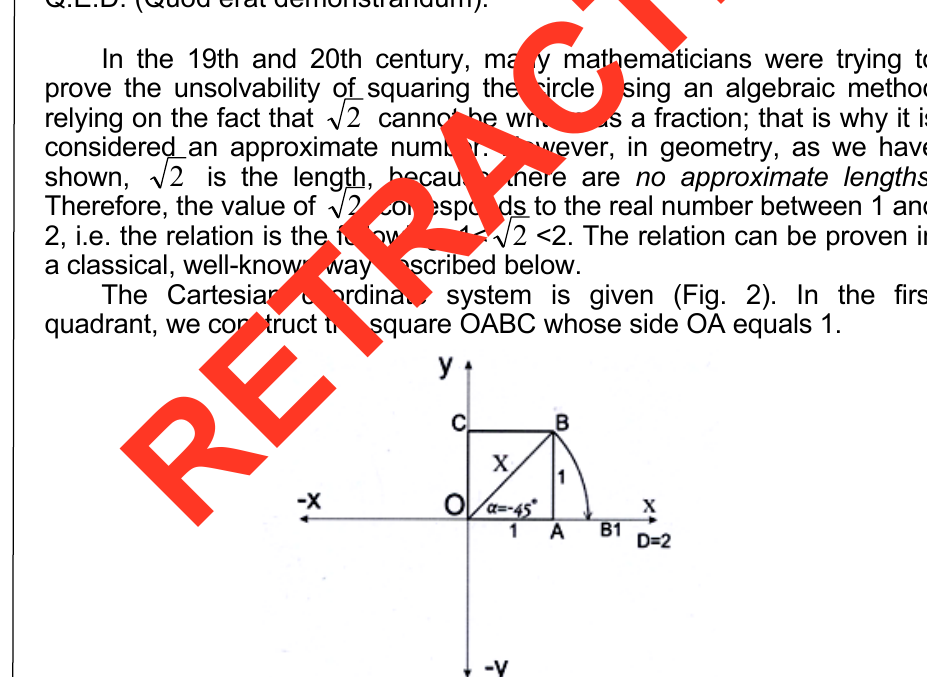
Figure 2 – Value of the length X between real numbers 1 and 2 Рис . 2 – Значение длины X между действительными числами 1 и 2 Слика 2 – B риједност дужи X између природних вриједности 1 и